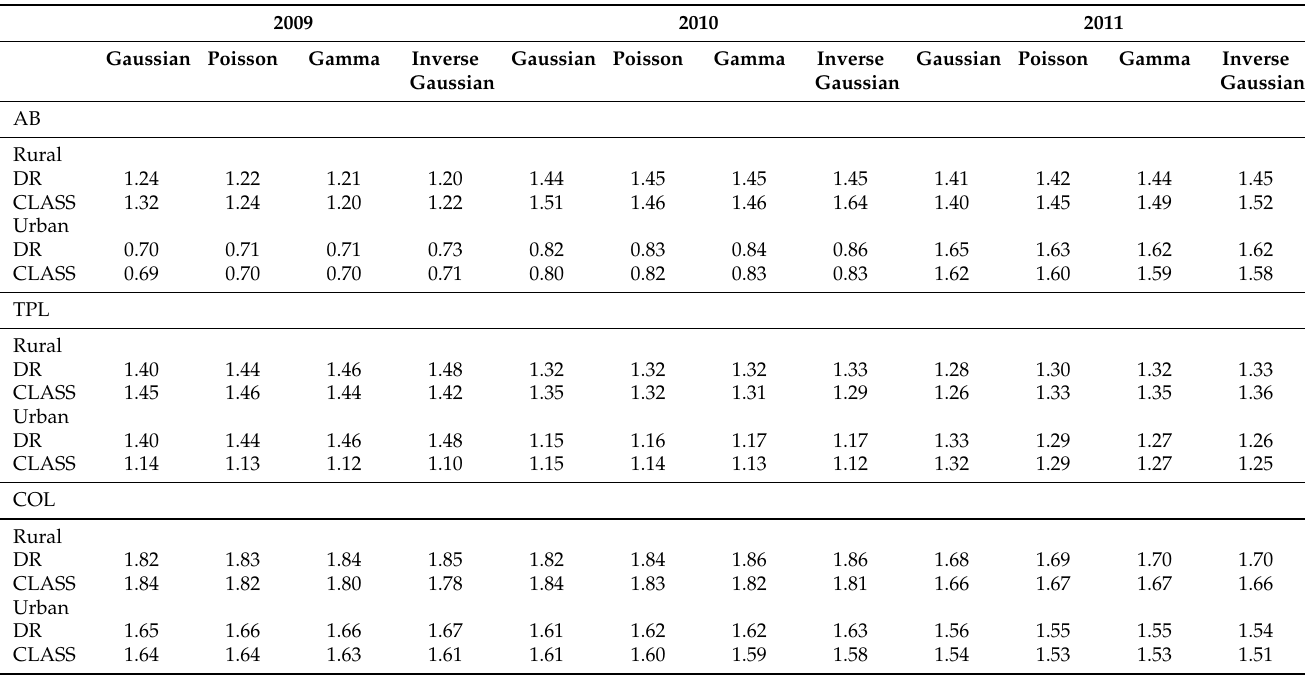
Table 6. The fixed effect estimates for DR and CLASS, separated by year, coverages and region, obtained from the one-way GLM.